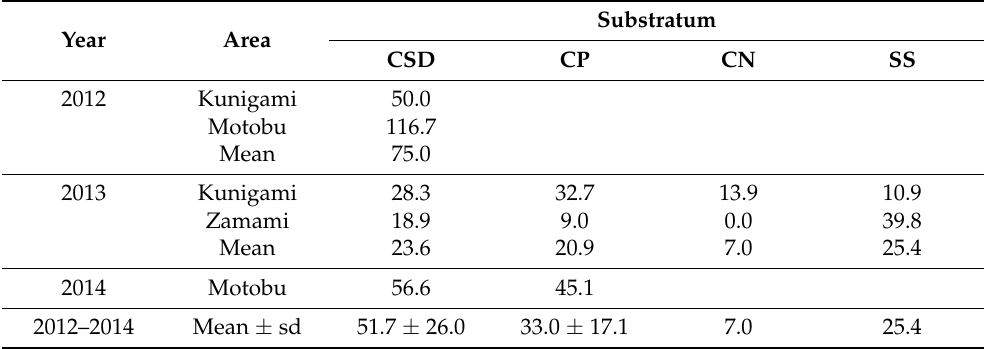
Table 5. Post-settlement survivorship and standard deviation (%) in the substrata.